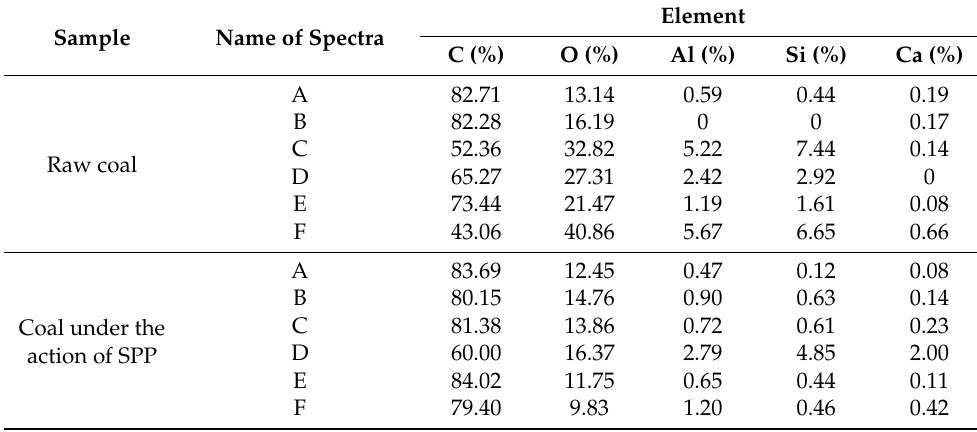
Table 3. EDS point scanning spectral analysis of coal sample.